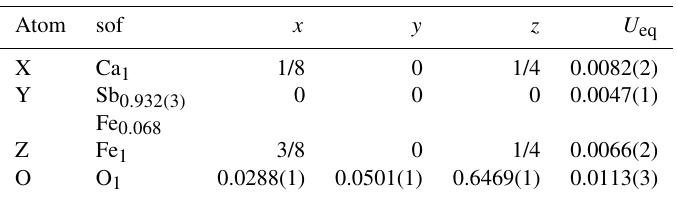
Table 6. Atoms, site occupancy factors (sof), fractional atomic coordinates and equivalent isotropic displacement parameters (Å 2 ) for the selected monteneveite crystal.